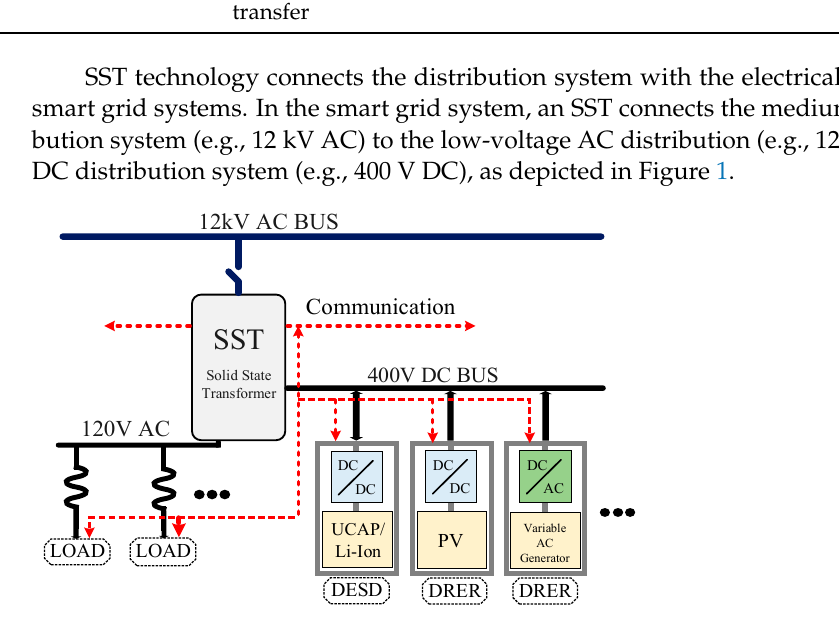
Figure 2, an SST is made up of three parts: an active rectifier, an active bridge converter